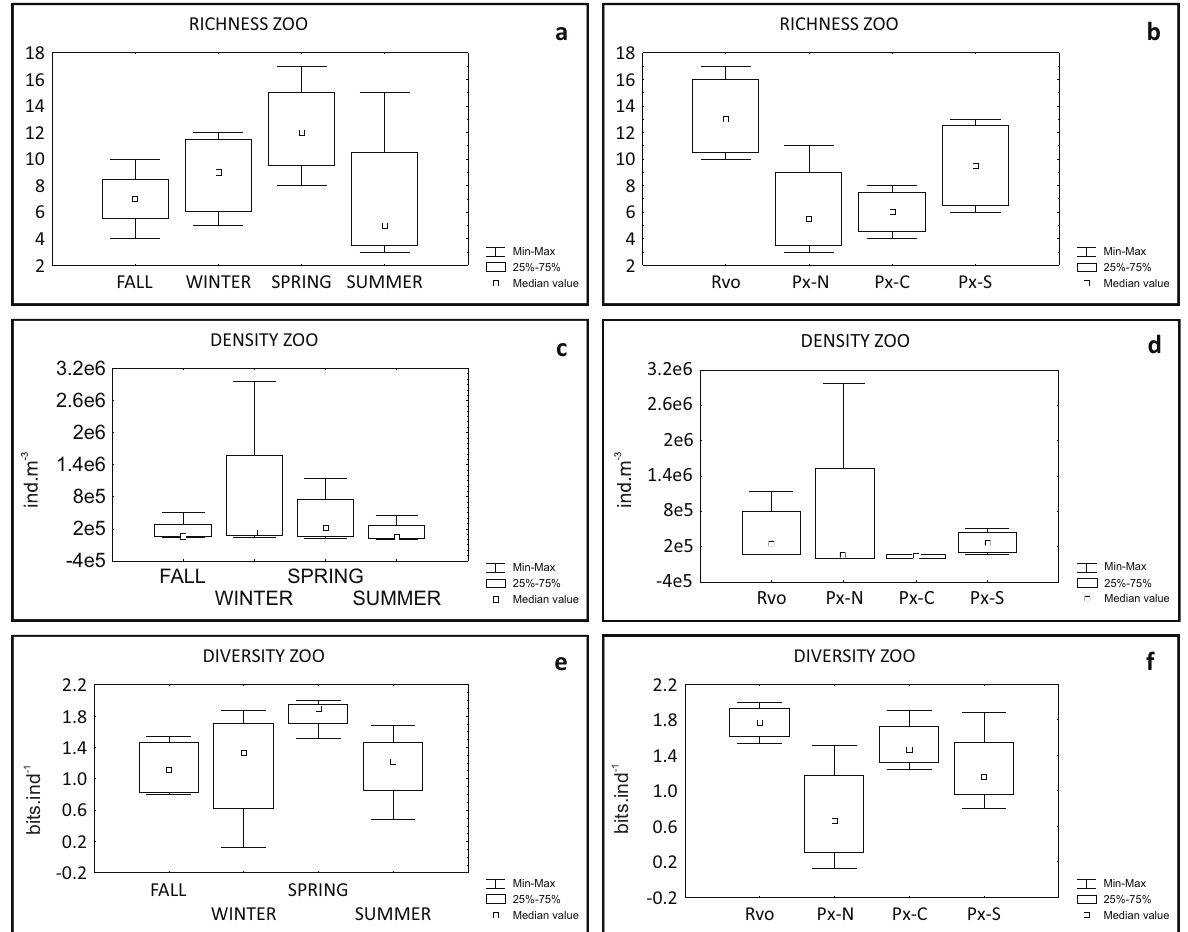
Figure 7 - Structure of the zooplankton community in the Ruivo and Peixe lagoons at seasonal (left) and spatial (right) scales. (Legend for locations see Table